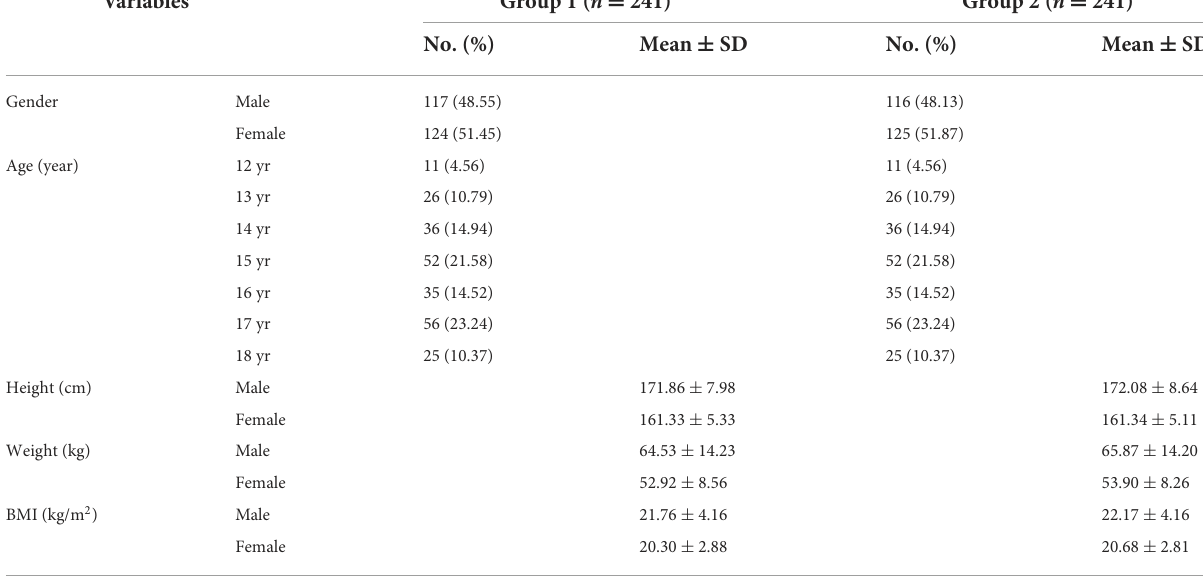
TABLE 1 Characteristics and anthropometrics for participants in two